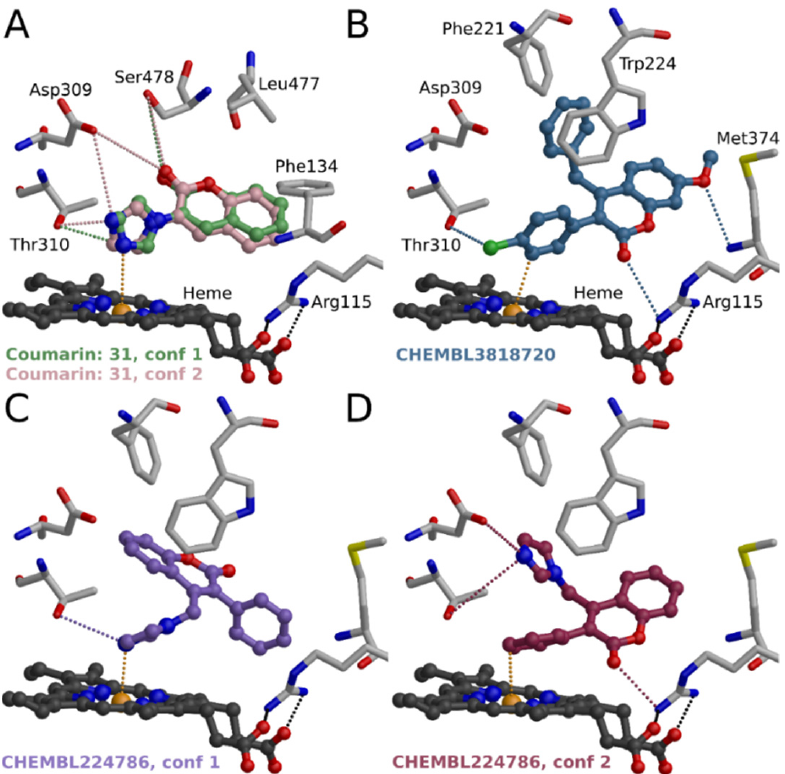
Figure 10. Binding of compound 31 and 3-phenylcoumarins to aromatase. ( A ) Comparison of possible binding conformations of 31 at the binding site of aromatase (PDB: 3EQM [22]). Nitrogen in the 3-imidazole ring of 31 coordinates either directly with heme (conformation 1) or forms hydrogen bonds with Asp309 and/or Thr310 (conformation 2). ( B ) Possible binding mode of CHEMBL3818720 [20]. The 3-phenyl ring could coordinate with heme. Possible binding modes of CHEMBL224786 [21] so either ( C ) imidazole ring or ( D ) 3-phenyl ring coordinates with heme.